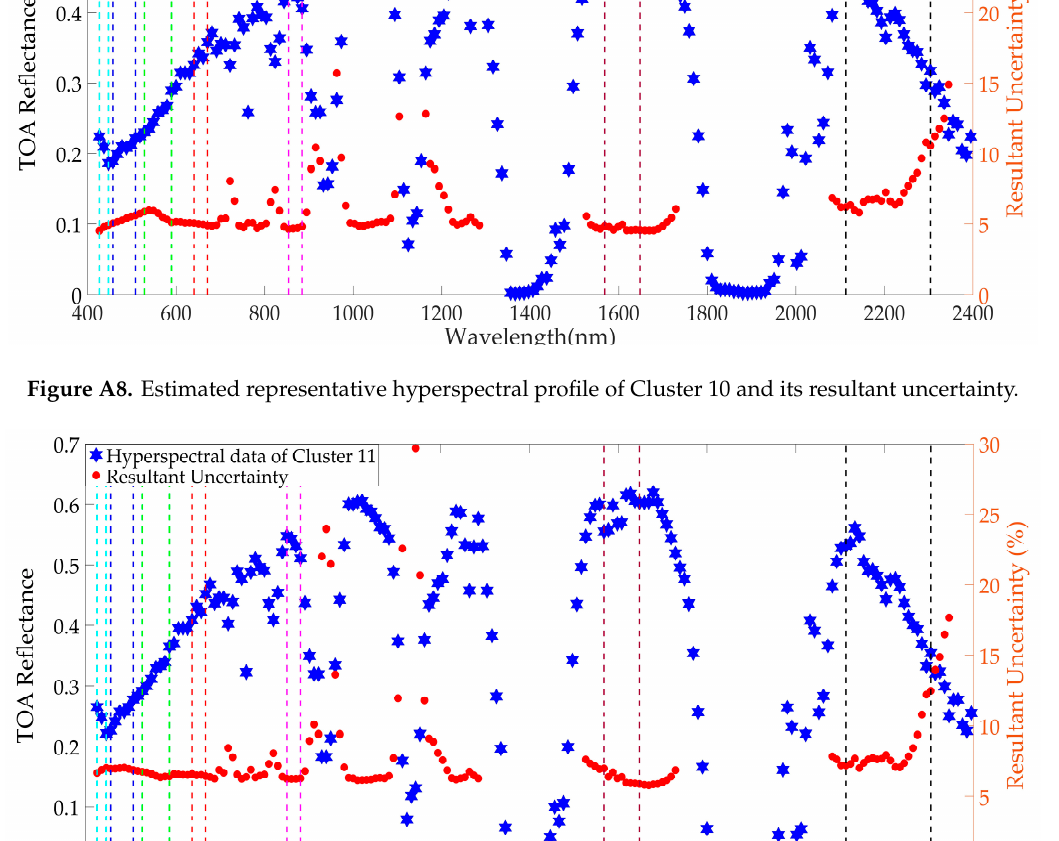
Figure A9. Estimated representative hyperspectral profile of Cluster 11 and its resultant uncertainty.